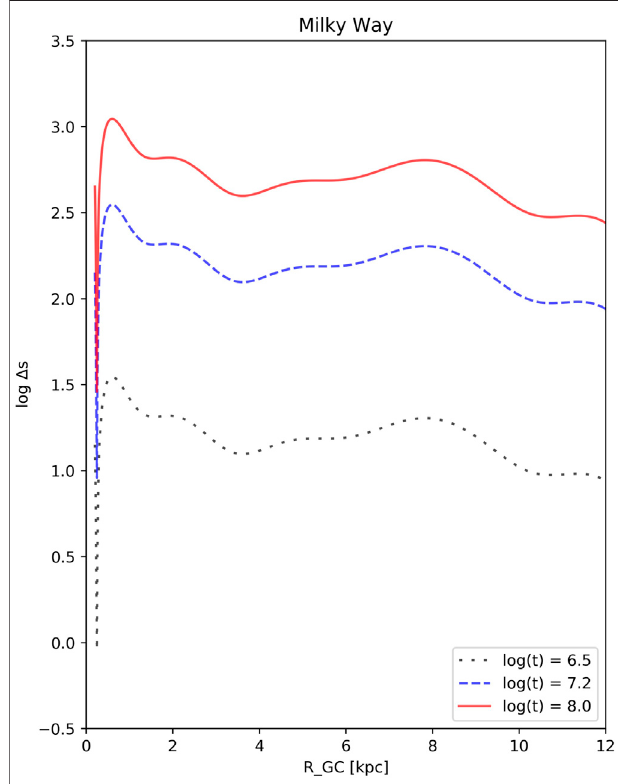
FIGURE 1 | The orbital drift of the open cluster in our Galaxy from their host spiral arm asafunctionofthe galacto-centricradiusand time.The values of Δ s under the logarithm are in parsec. Used parameters: Ω p (cid:1) 25 km/s/kpc, Δ R (cid:1) 0 . 1 kpc,rotationcurvefromSofueetal.(1999),approximatedbya high-degree polynomial (deg >